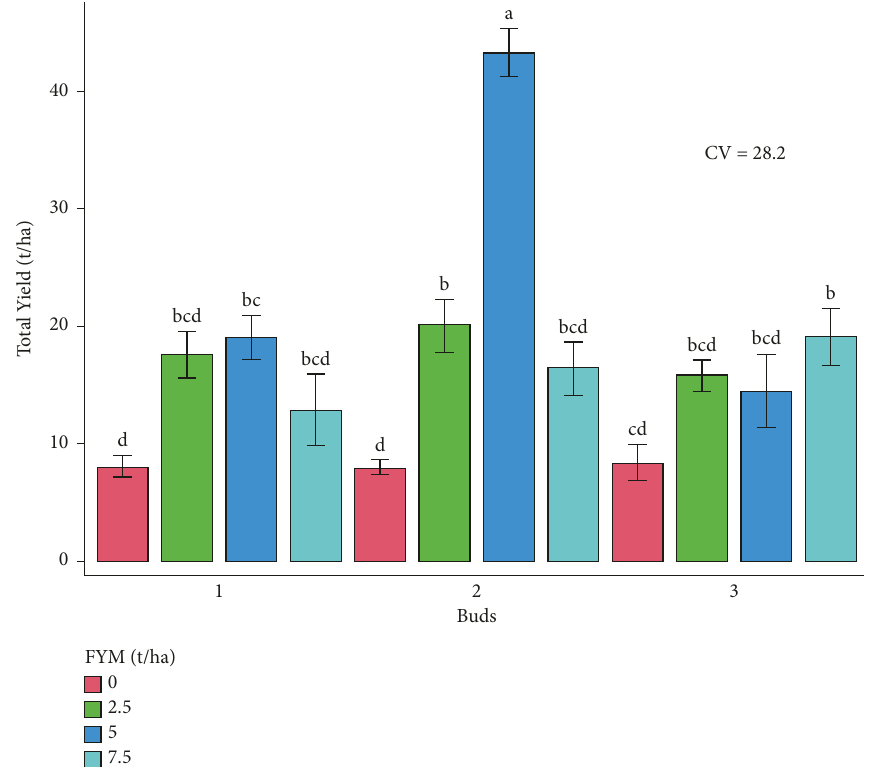
Figure 5: Total yield as influenced by the interaction effect of bud numbers and farmyard manure fertilizer